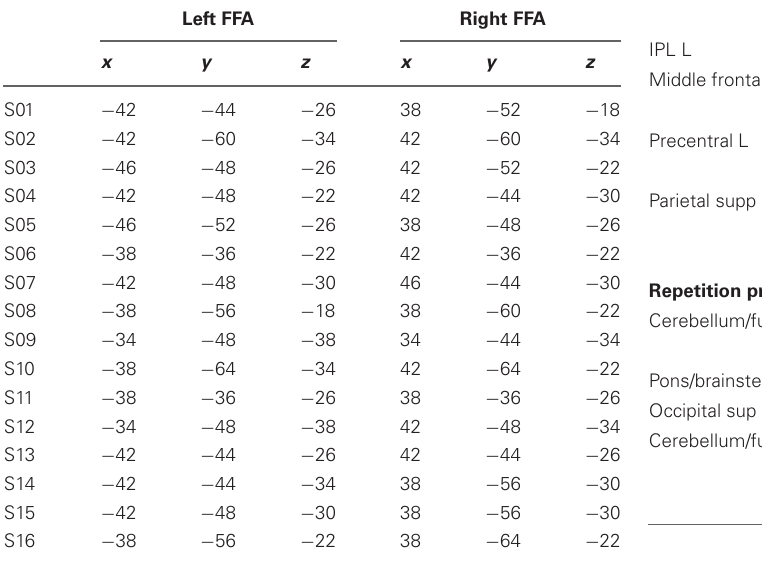
Table A1 | Coordinates for the center of individual FFA (MNI convention, units are mm).